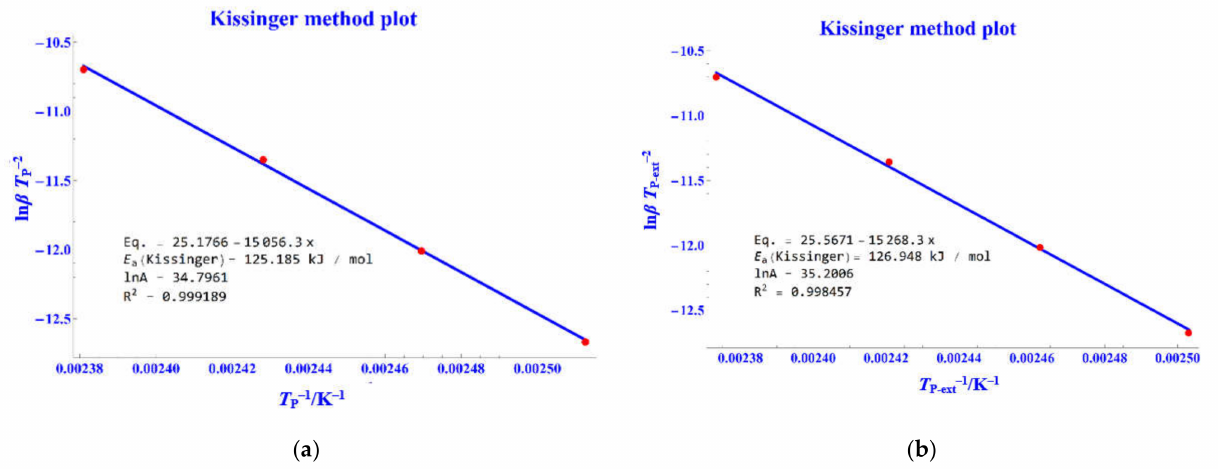
Figure 13. ASTM E2890 method plot ( a ) ln β / T P2 versus 1/ T P plot; ( b ) ln β / T P2 versus 1/ T P-ext plot.